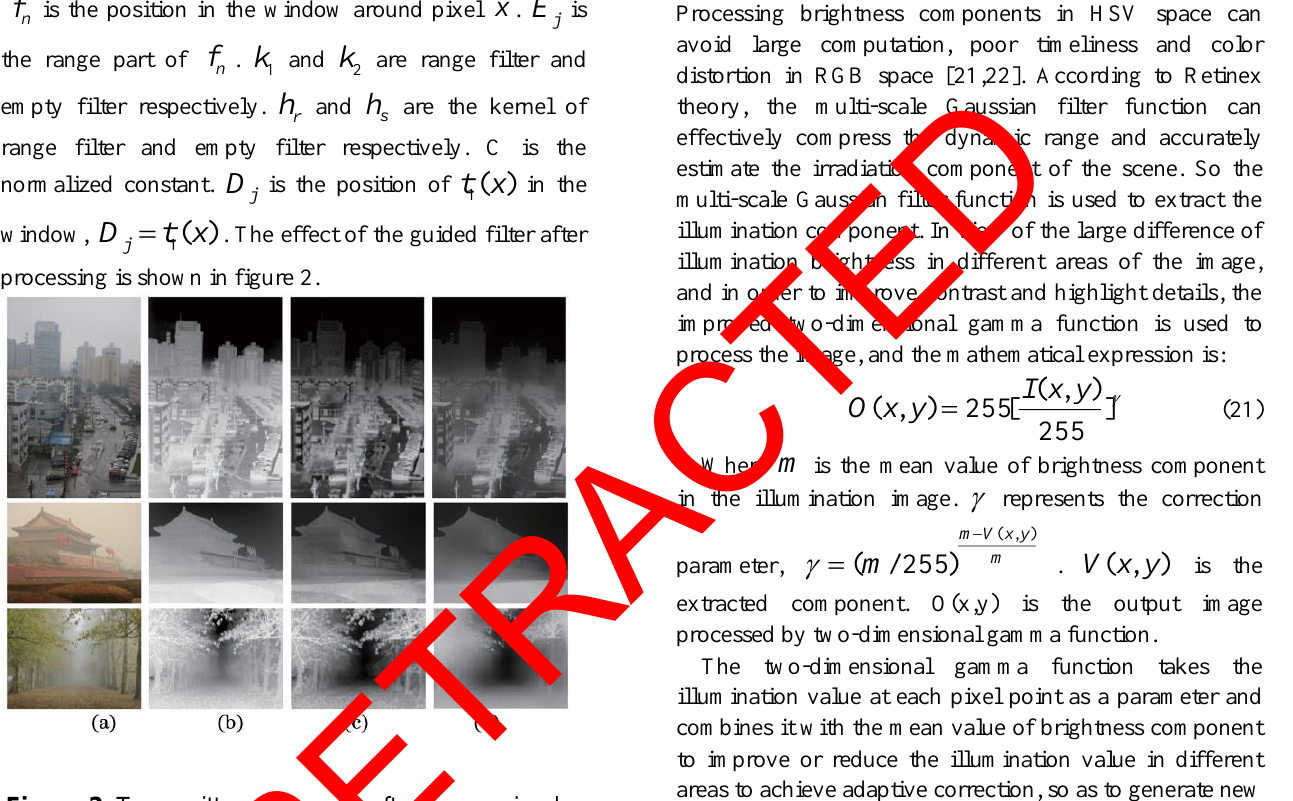
Figure 2. Transmittance images after processing by different methods. (a) Hazy images; (b) Ref. [8]; (c) rough estimations of transmittance; (d)